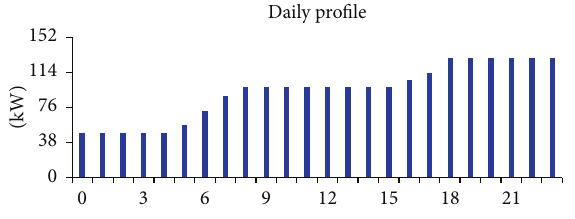
Figure 8: Daily load profile of hypothetical village.